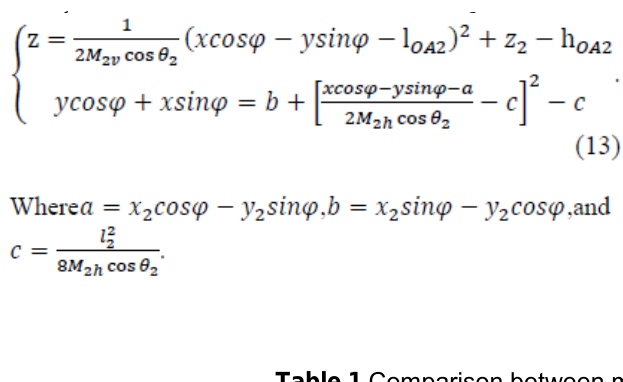
Table 1. Comparison between manual and system